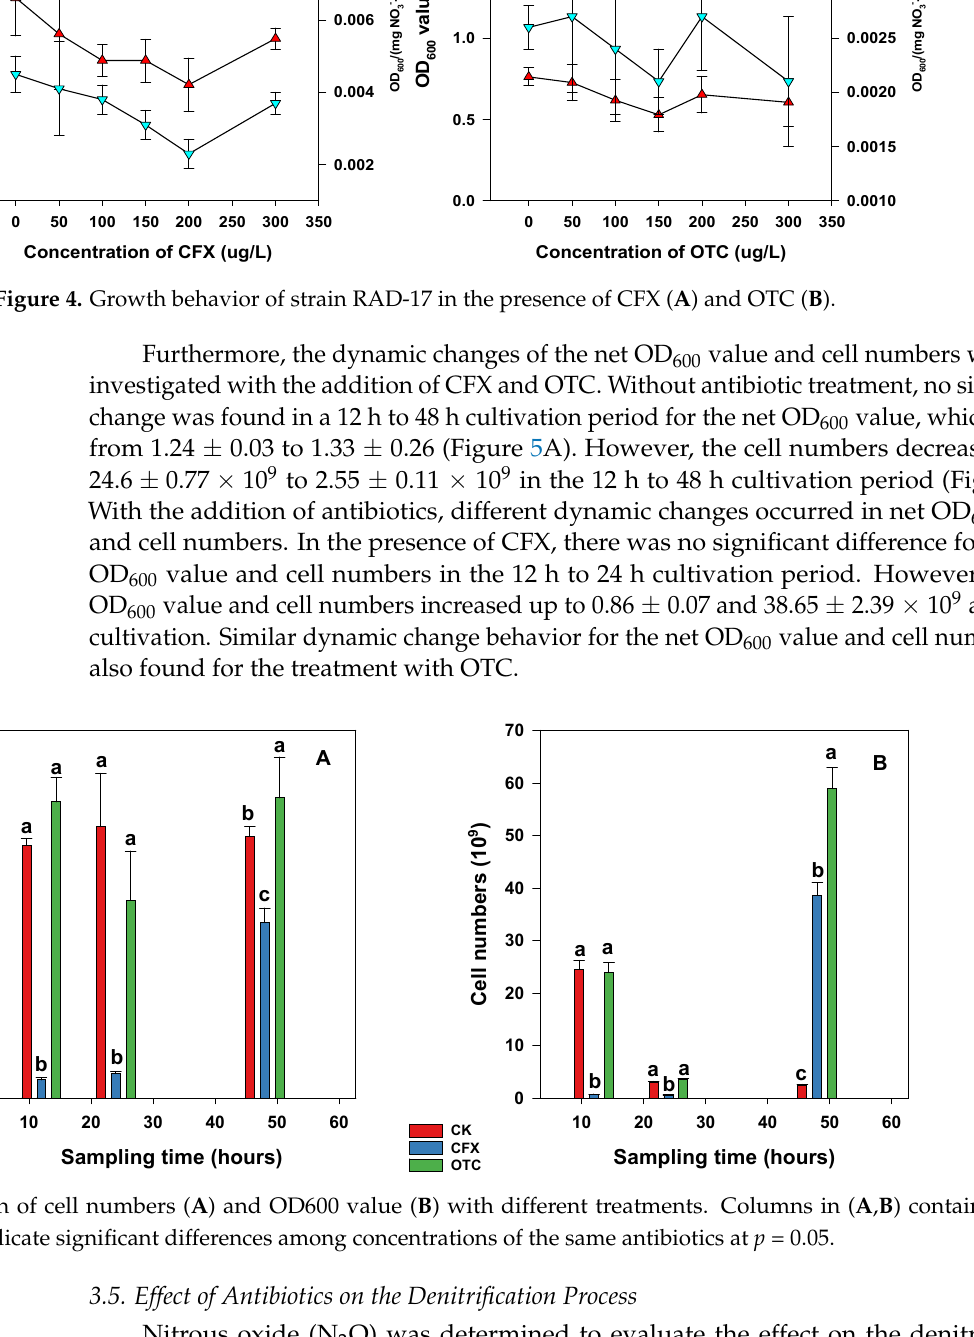
Figure 5. Variation of cell numbers ( A ) and OD600 value ( B ) with different treatments. Columns in ( A ) and ( B ) containing different letters indicate significant differences among concentrations of the same antibiotics at p = 0.05.